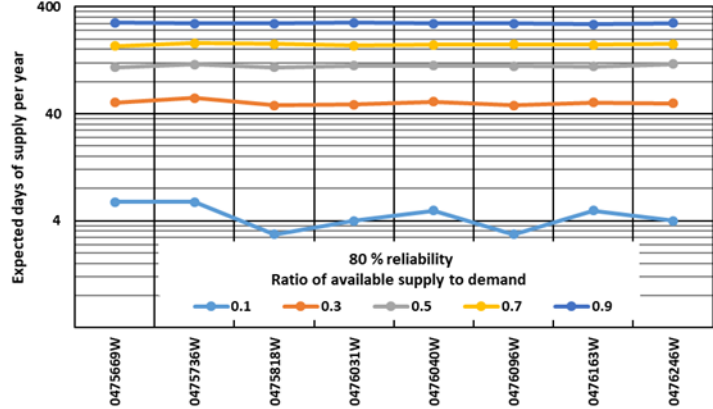
Figure 2. Typical variation of days of supply for different rainfall stations.